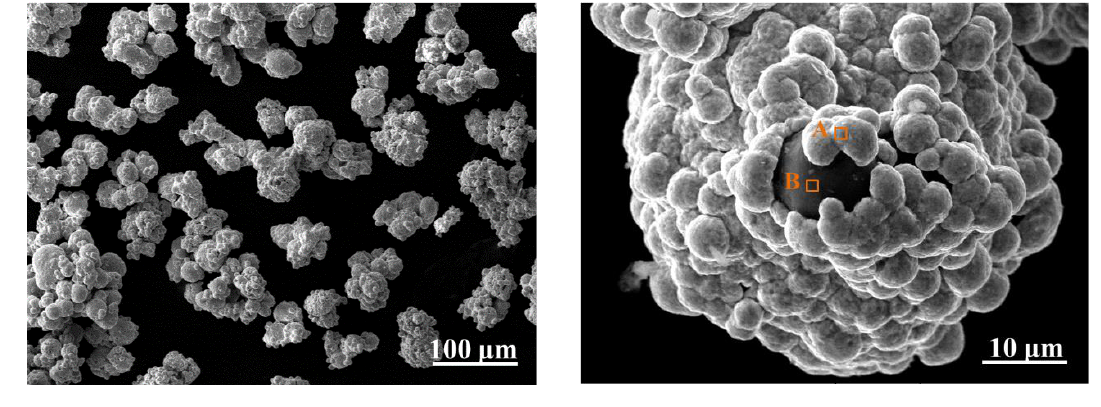
Figure 1. Micromorphology ( a ) and partially enlarged details ( b ) of Ni80Al20 alloy powder.